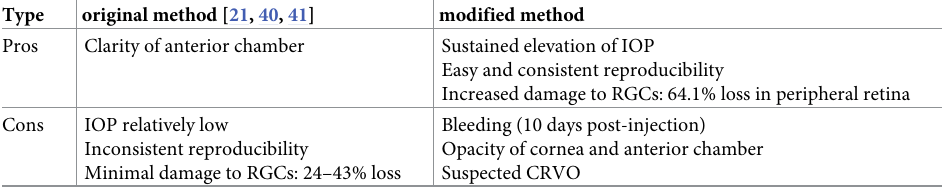
Table 2. Pros and Cons between the original and modified